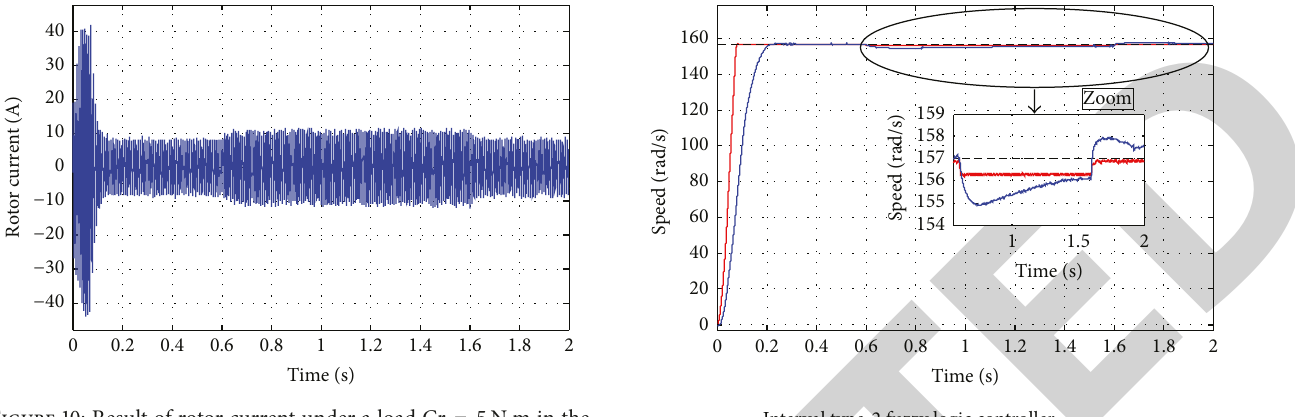
Figure 10: Result of rotor current under a load Cr = 5 N ⋅ m in the interval [0.6Sec–1.6 Sec].